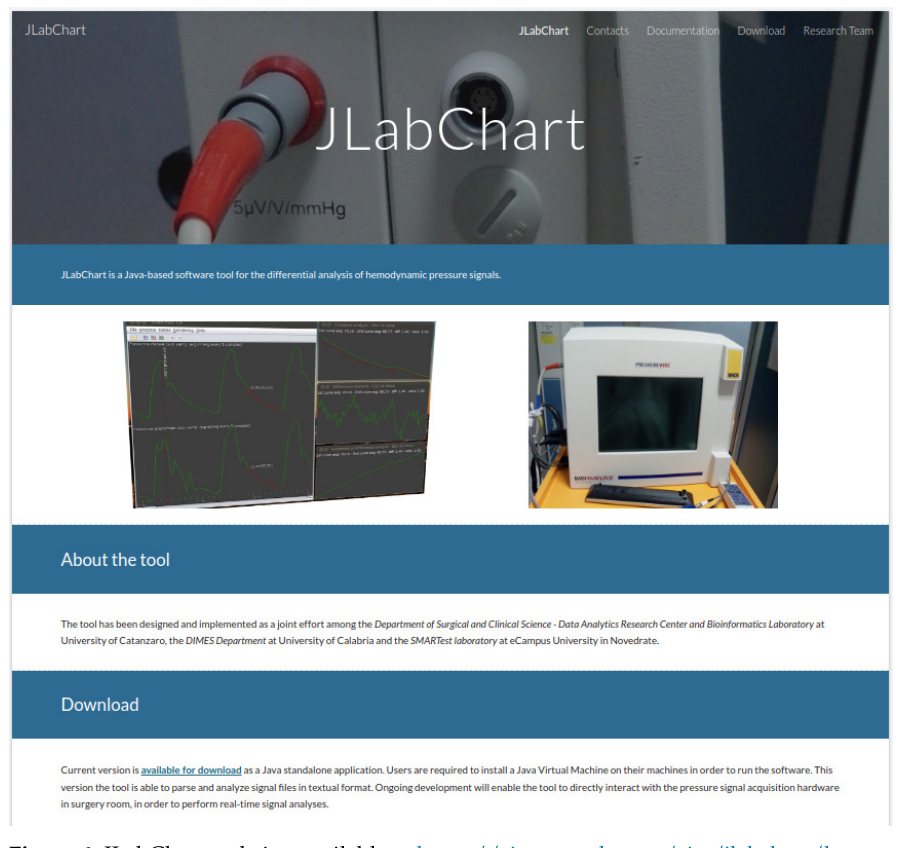
Figure 6. JLabChart website, available at